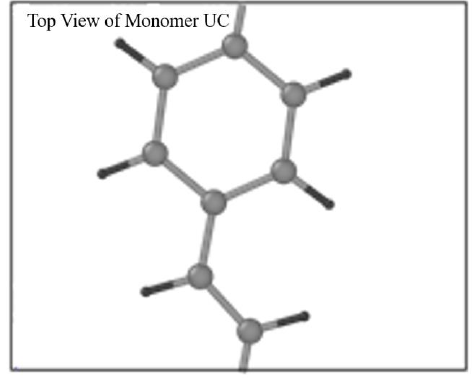
Figure 2. Top view of PPV monomer in unit